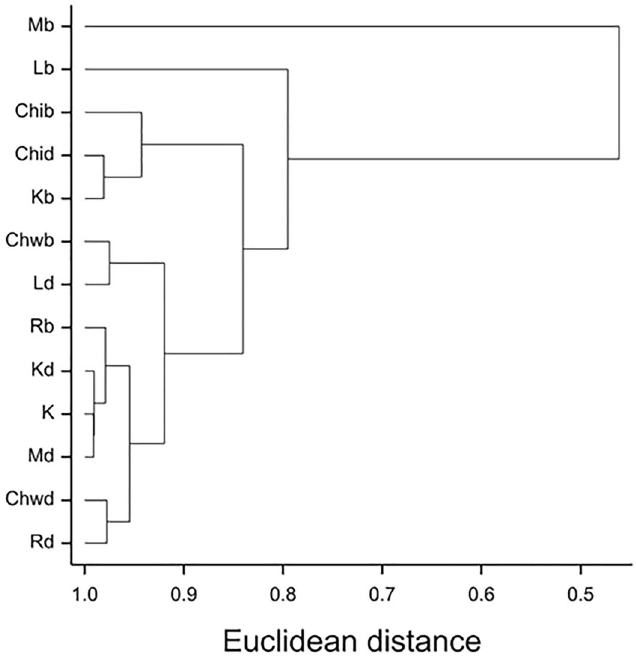
Figure 7. Dendrogram of cluster groupings for combinations of herbicides and application methods based on all seven quantitative traits. Combinations: K – trees without any treatment, Kd – trees with drilling, Kb – trees with bark incision as well as five different herbicides: Chi – Chikara, Chw – Chwastox, L – Logo, M – Mustang, R – Roundup and two methods of their application: d – drilling or b –